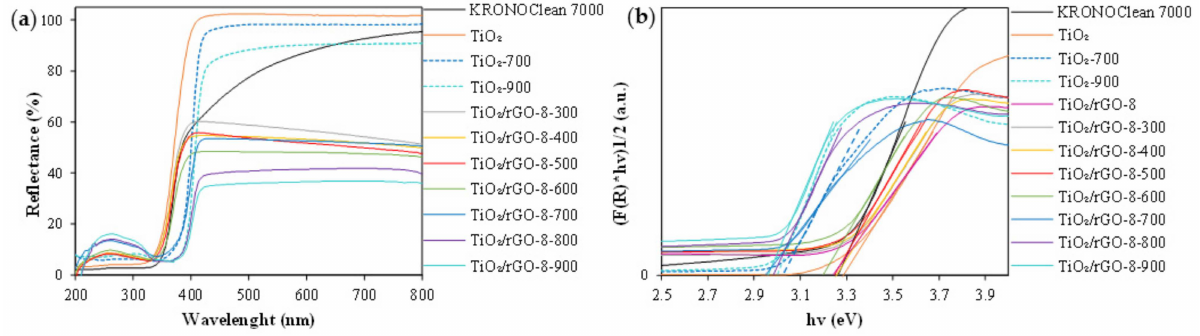
Figure 1. UV–Vis/DR spectra ( a ) and Tauc plot ( b ) for reference, control, and obtained